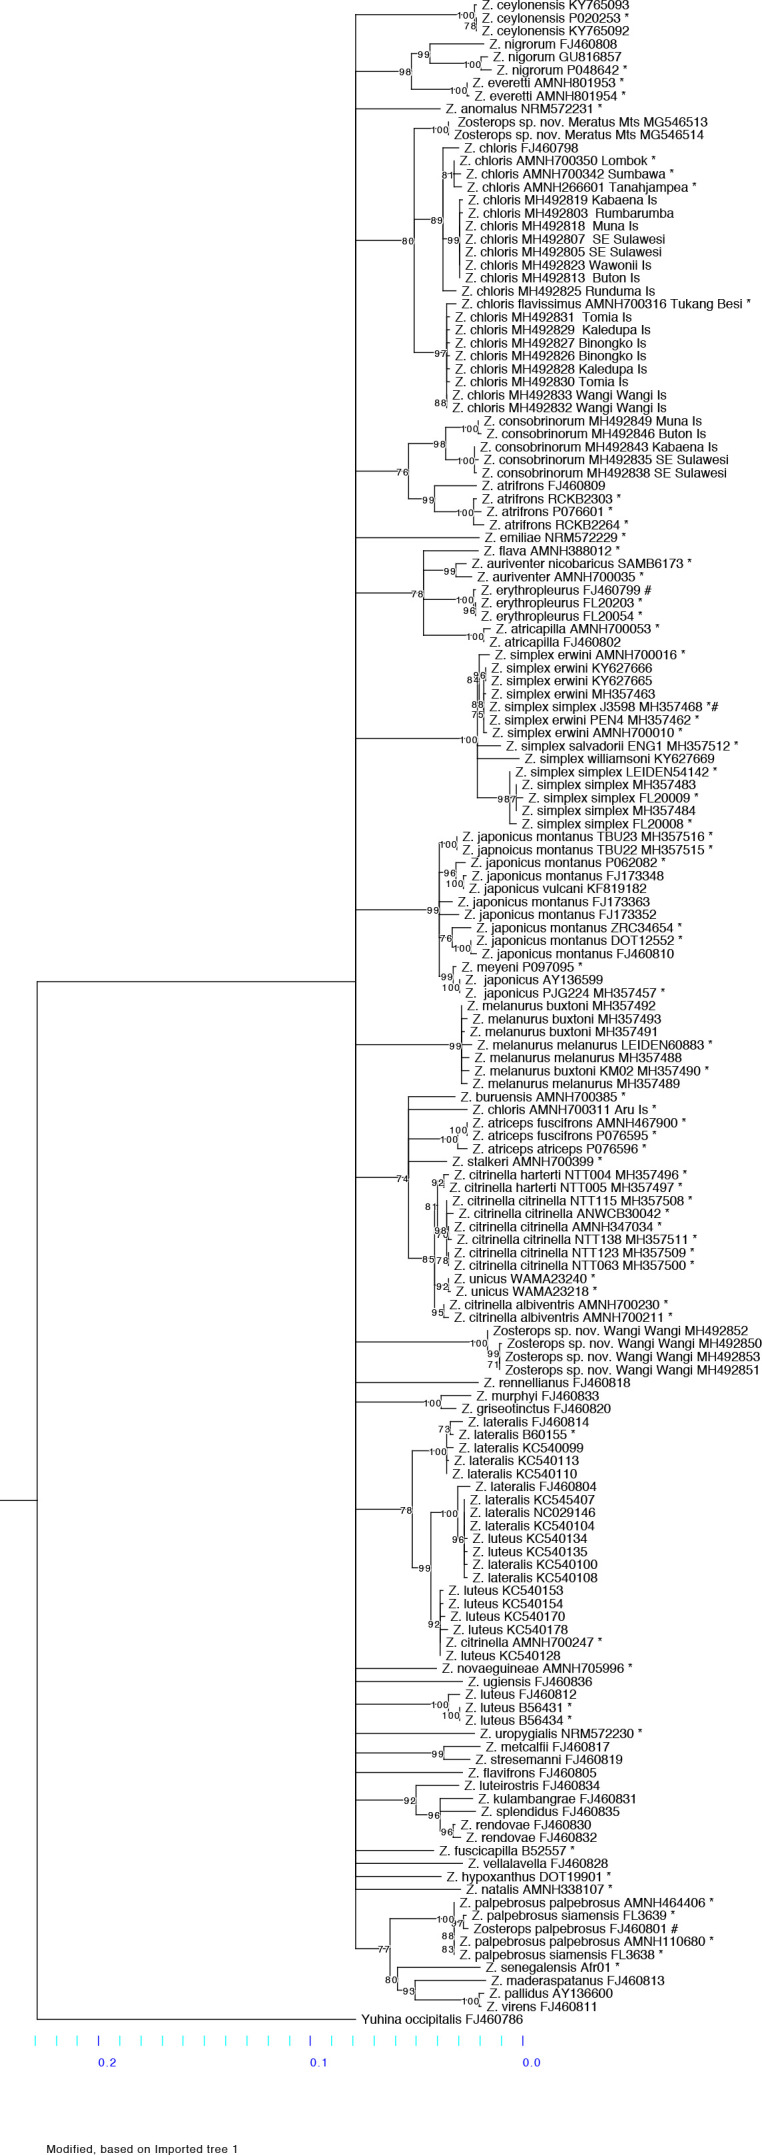
Maximum likelihood phylogeny constructed with RaxML using a mitochondrial ND2 gene alignment of 1041 base pairs.Nodes with a bootstrap value below 70 were collapsed. The scale at the bottom depicts the branch length of the ND2 tree. Samples from our study are marked with * at the end the sample name. Three mislabeled samples obtained from GenBank are each marked with # at the end of the GenBank accession number and assigned to the correct taxon.